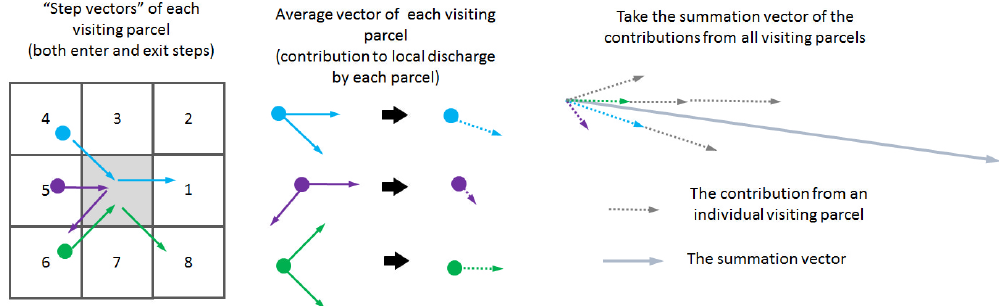
Figure 4. Calculation of the direction of the cell-representative discharge vector. The representative discharge vector takes the direction of the summation vector of all contributions from each visiting water parcel, and for N visit -visiting parcels its magnitude is N visit Q p_water .